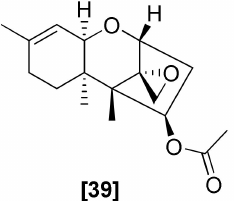
Figure 11. Structure of antifungal trichothecene: [39] trichodermin from Trichoderma